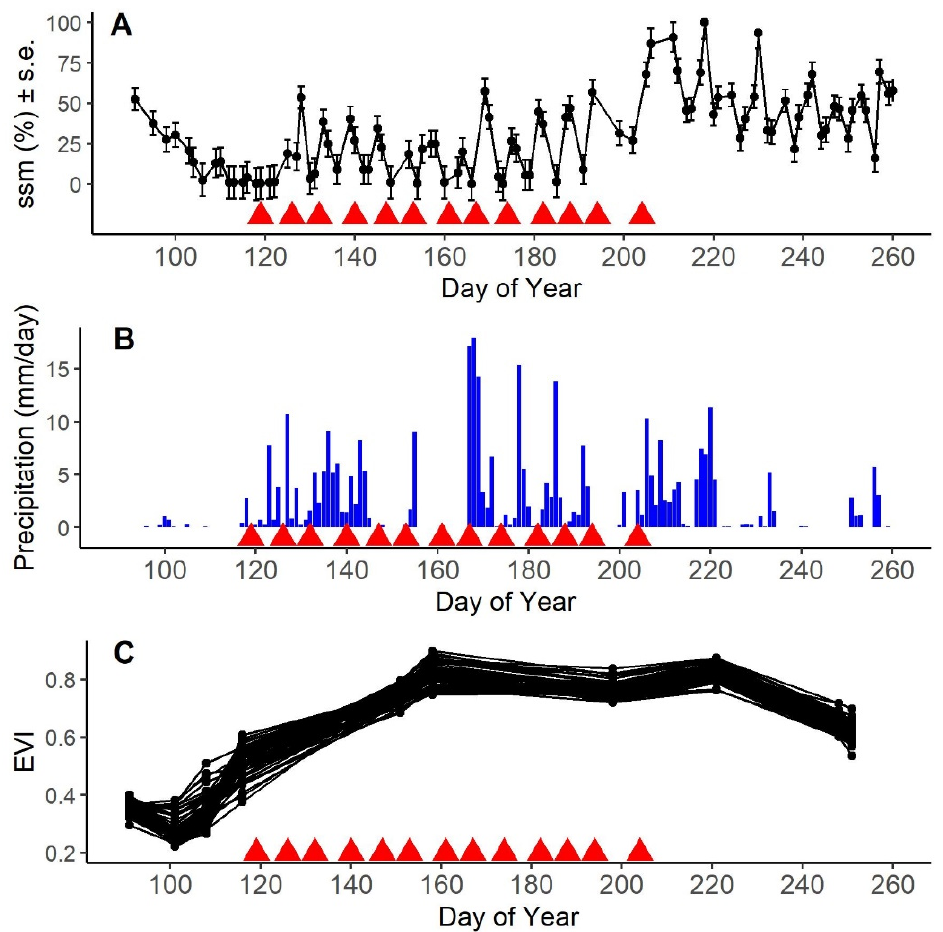
Figure 2. ( A ) Satellite-derived time series of surface soil moisture (Sentinel-1) at a 1-km resolution; ( B ) regional daily precipitation averages; ( C ) the site-based green-up trajectory using EVI (Sentinel-2) at a 10-m resolution. The 13 field sampling dates are shown as red triangles.